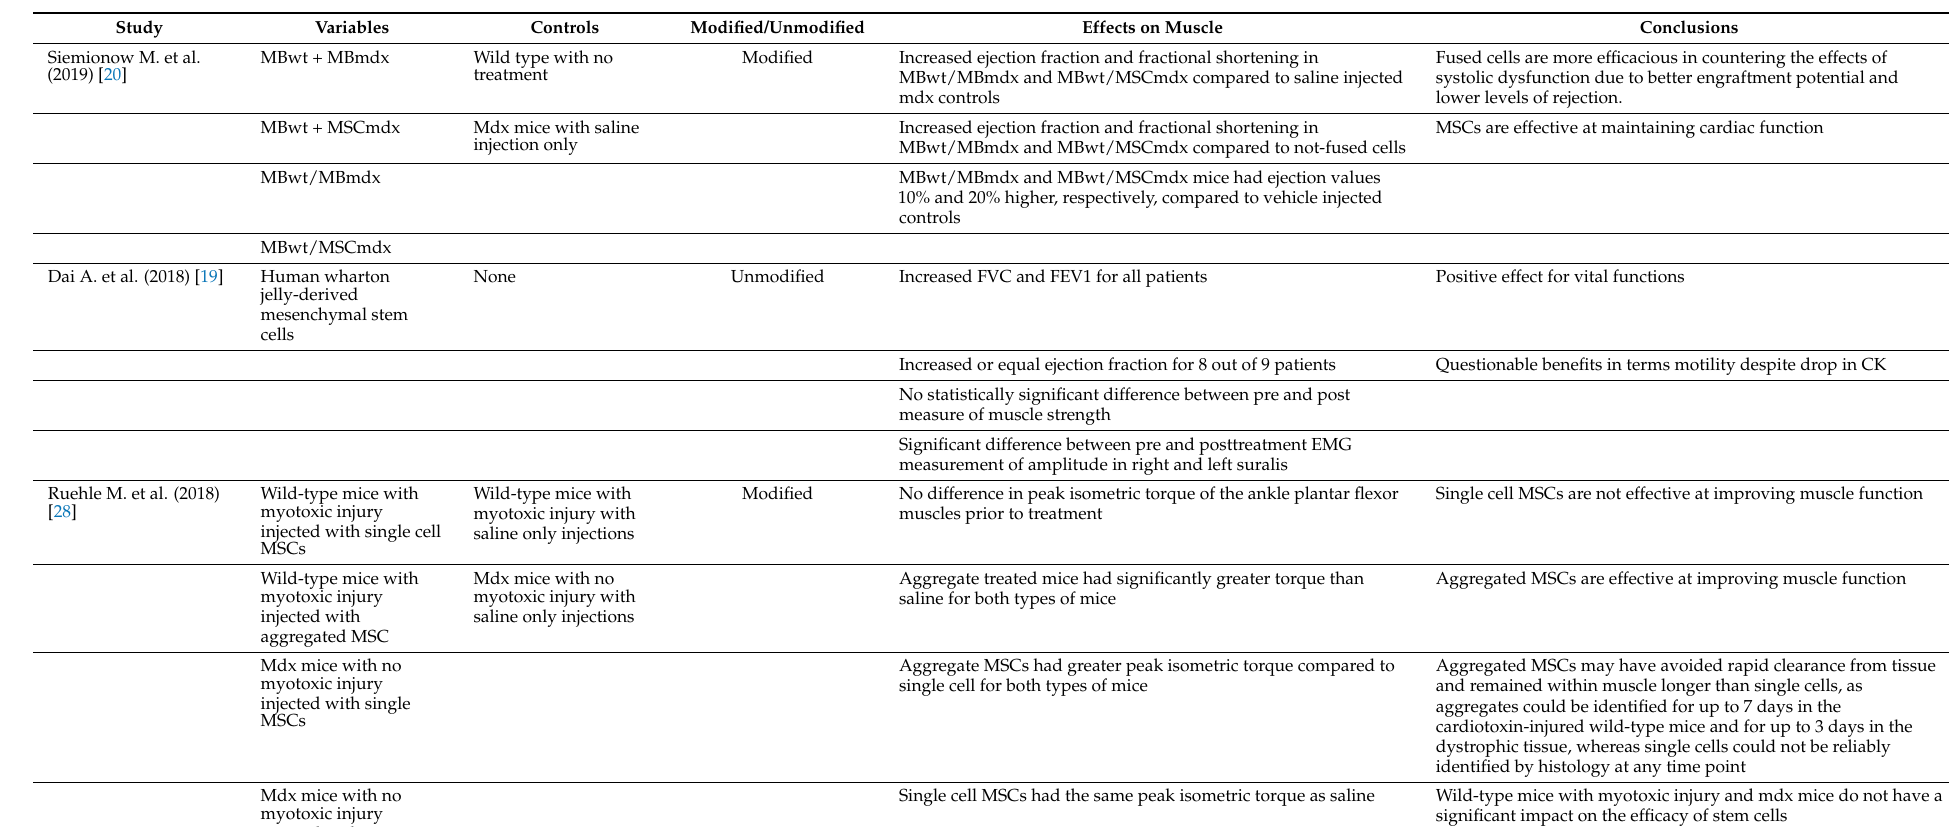
Table 4. Experimental variables, results, and conclusions of selected